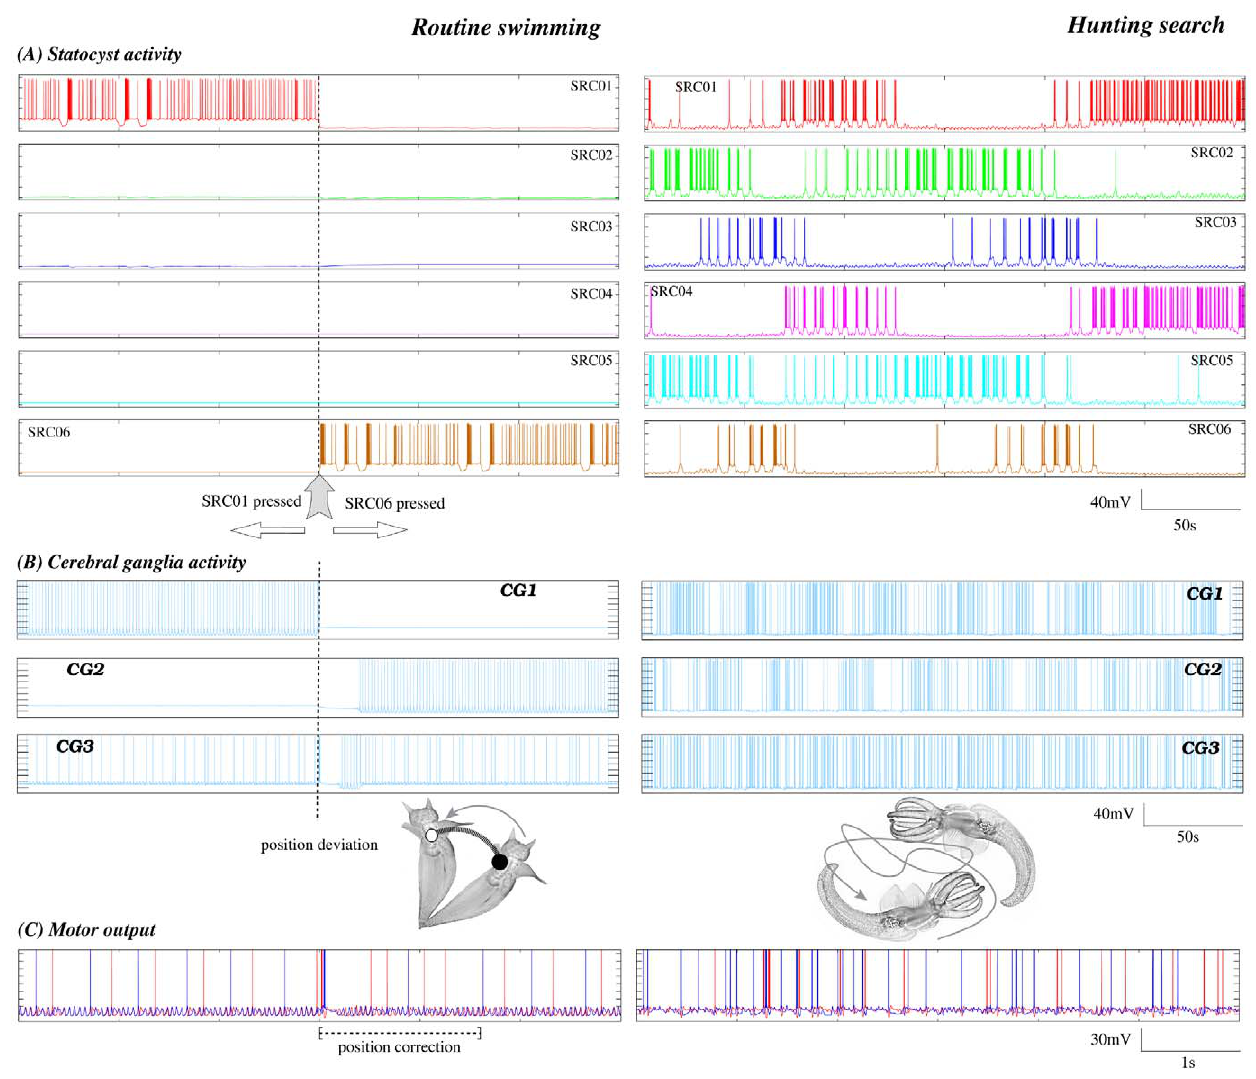
Figure 3. The behavior of the model network. Left panels: Routine swimming activity pattern, in the absence of the hunting neuron excitation (c.f. Figure 1, left panel). Right panels: Search hunting behavior activity pattern when the hunting neuron is activated (c.f. Figure 1, right panel). (A) Behavior of the SRC model network. During routine swimming the model statocyst network shows a winner take-all dynamics. Only the SRC pressed by the statolith fires (and thus inhibits other SRCs connected to it). In the first part of the time series, the active neuron in the statocyst network is SRC01. A simulation of body orientation change by exciting SRC06 (denoted by the arrow) makes the new pressed SRC fire immediately while SRC01 becomes silent like the rest of the SRCs. The winnerless competition dynamics (WLC) appears in the statocyst model when the hunting neuron is activated. The irregular sequential activations of the WLC activity displayed by the model are very similar to the one observed in the biological circuit (see Figure 2). (B) Behavior of the CG network located between the statocyst and the wing CPG. During routine swimming either CG1 or CG2 is active, depending on which of the SRCs receives the excitation from the statolith. The CG3 cell integrates and sends this information to the CPG. When a deviation from the preferred position occurs, the identity of the active SRC pressed by the statolith changes and the cerebral interneurons interpret this change (see panel C). During hunting, both CG1 and CG2 cells are active. (C) Behavior of the wing CPG model responsible for generating the periodic wing beating rhythm. As in the biological circuit (Figure 6) the activity of the wing CPG model is affected by the statocyst dynamics which is evoked by the behavioral context. During routine swimming, the model CPG generates a regular rhythm. During the hunting behavior the pattern is faster and highly irregular. Note that during routine swimming, when a change of posture is simulated, the sensory information received in the wing CPG immediately generates a corrective activity. Here, for example, the change from SCR01 to SCR06 produces a short change in the frequency and shape of the rhythm. Afterward, the typical repetitive rhythm is